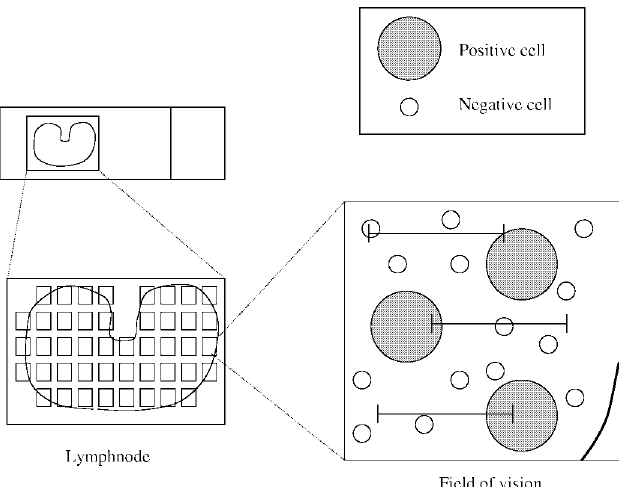
Fig. 2. Schematic illustration of the systemic random sampling method used to develop a protocol for interactive stereological immunoscoring with a cytoplasmatic marker. Fields of vision are systematically distributed throughout the entire lymph node. A six points Weibel-grid was used to count the positive cells in each field of